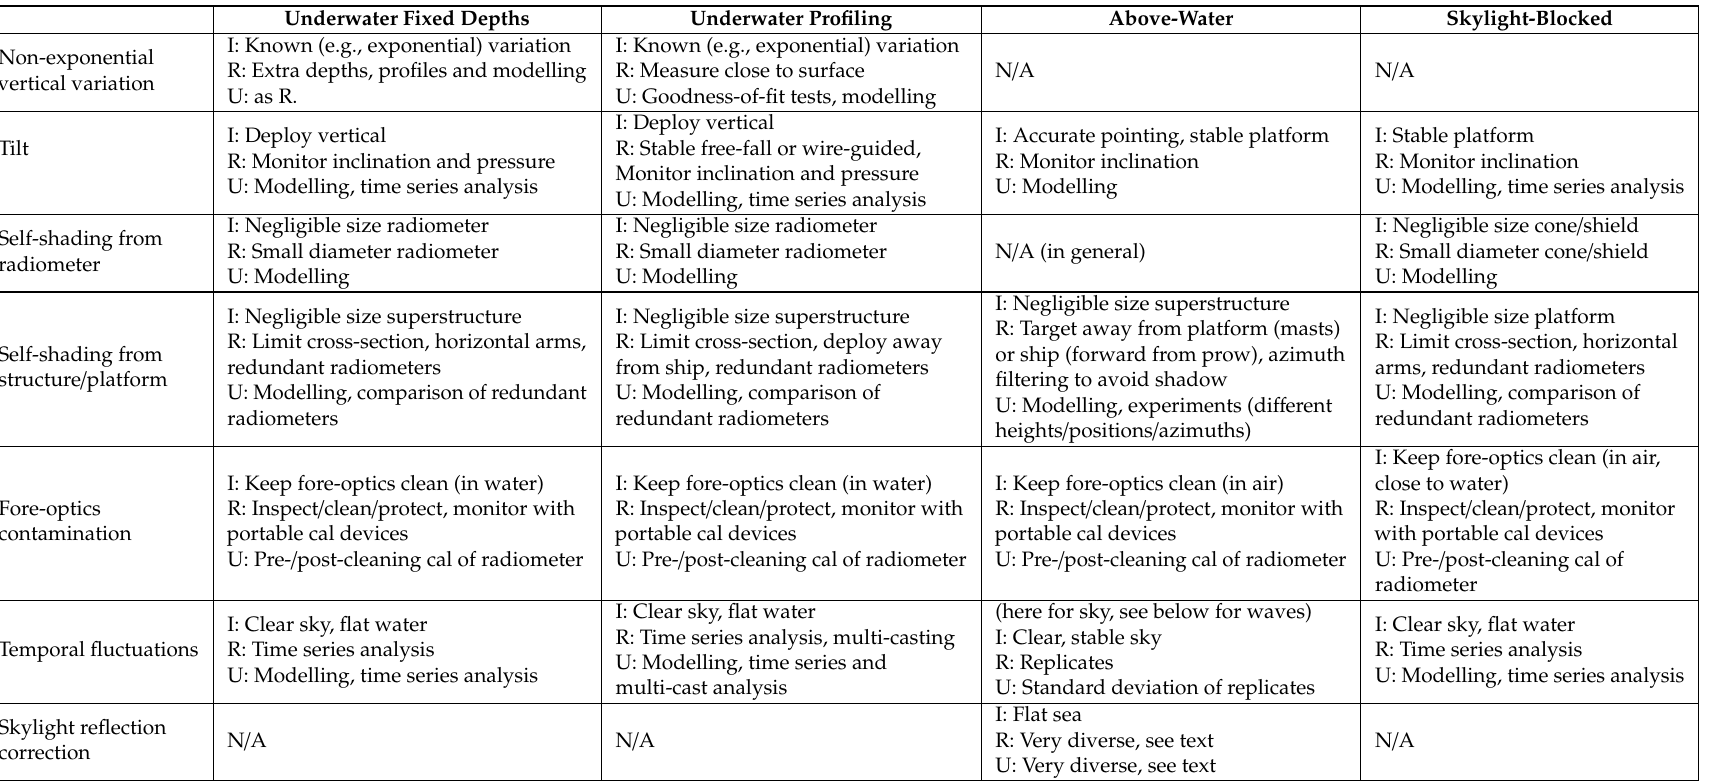
Table 2. Summary of the four measurement methods as regards protocol-related uncertainty estimation. I = Ideal conditions; R = Recommendations; U = Uncertainty estimation. Cal = calibration. N / A = not applicable. See text for more details on each topic. Depth measurement and Fresnel transmittance should also be included in the uncertainty budget for the underwater fixed-depth and profiling methods, but are not included in the table. Radiometer-related uncertainties must also be estimated for all methods but are beyond the scope of this